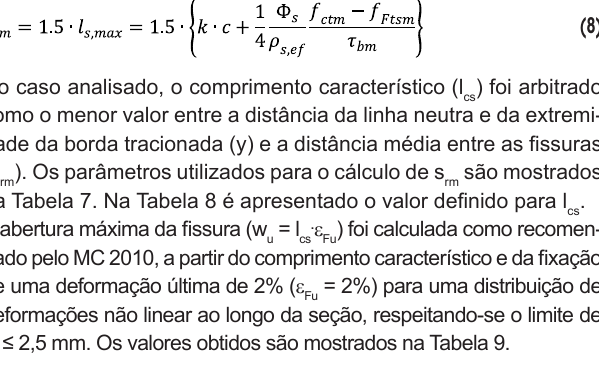
na Tabela 7. Na Tabela 8 é apresentado o valor definido para l